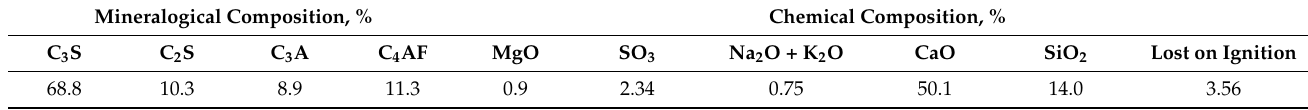
Table 2. Mineralogical and chemical composition of Portland